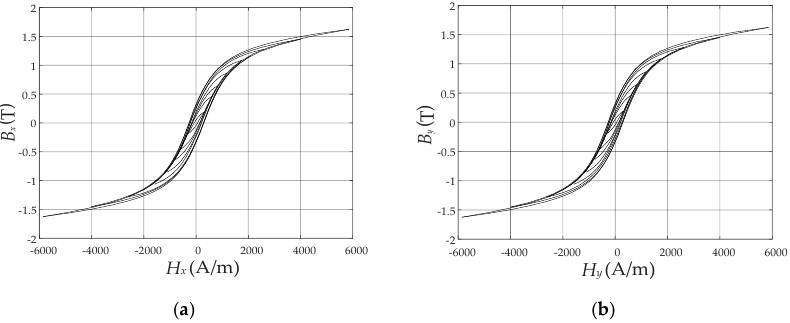
Figure 3. Measured hysteresis curves: ( a ) Locus of vector B ; ( b ) Locus of vector H . The measured concentric hysteresis loops along two orthogonal directions, i.e., x direction and y direction, are shown in Figure 4. The hysteresis curves at the saturated magnetic flux density are the limiting hysteresis loops required for identification of the Preisach model.